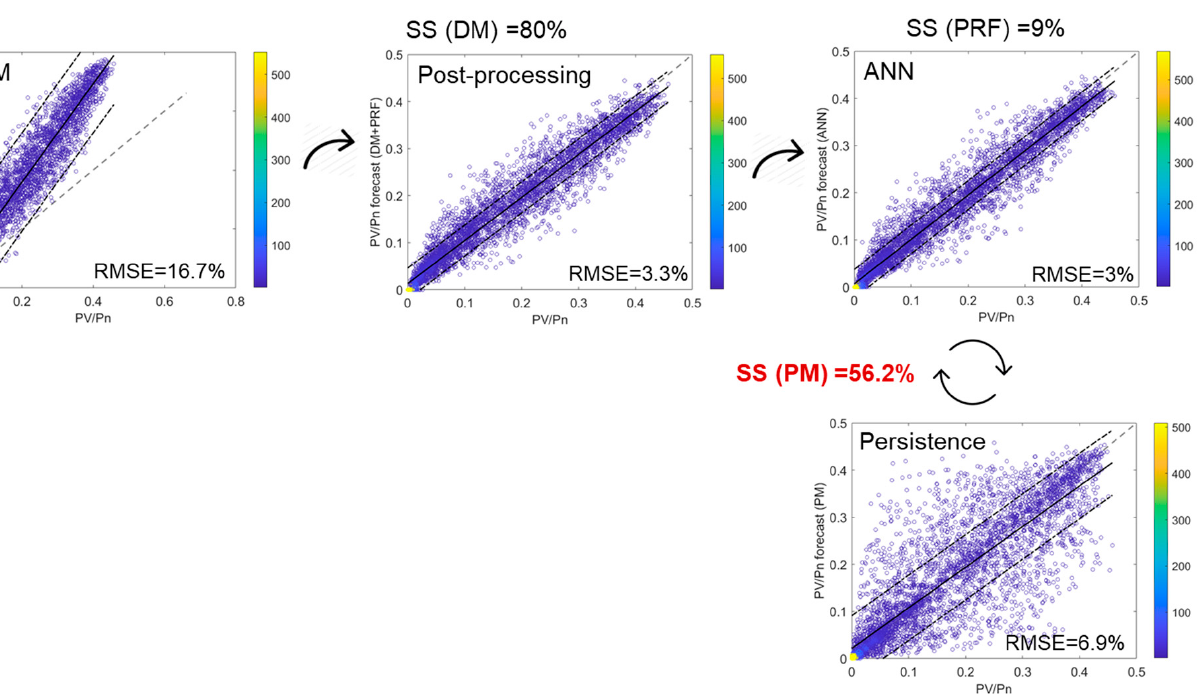
Figure 7. Scatterplots (forecast vs. observation) of the different forecasts used for the PV power prediction of the north zone (the zone with higher PV installed capacity): Deterministic forecast (DM), DM after post-processing, ANN Hybrid model prediction.